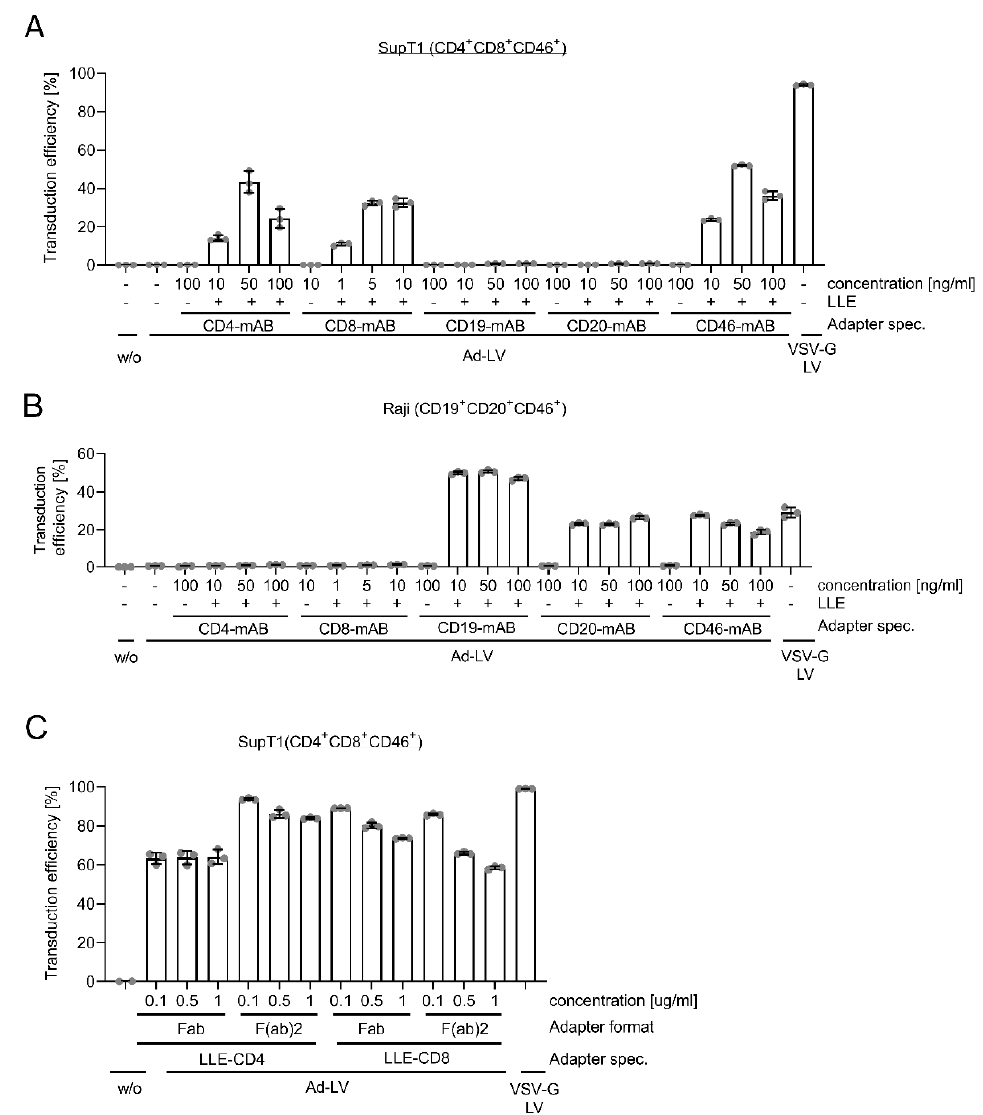
Figure 3. Flexibility of Ad-LV towards adapter specificity and format. The flexibility of the adapter system was evaluated by transduction of cell lines using different adapter specificities. SupT1 (CD4 + CD8 + CD46+) ( A ) and Raji cells (CD19 + CD20 + CD46+) ( B ) were left untreated (w/o) or were transduced with GFP-encoding Ad-LV with 0.2 TU/cell using LLE-CD4 (clone: MT-466), LLE-CD8 (clone: BW135/80), LLE-CD19 (clone: LT19), LLE-CD20 (clone: LT20), and LLE-CD46 (clone: REA312) mABs (+) in concentrations ranging from 1 to 1000 ng/mL. Non-biotinylated mABs (-) used in the highest concentration and transduction in the absence of any adapter (-) were used to confirm specificity. VSV-G LV was used as reference. Transduction efficiency was analyzed 3 days (Raji) or 4 days (SupT1) post transduction via quantification of GFP-positive cells using flow cytometry. ( C ) Transduction efficiency of SupT1 comparing fab and f(ab) 2 adapter formats of the same LLE-CD4 or LLE-CD8 clone with adapter concentrations ranging from 0.1 to 1 µg/mL using a GFP-encoding Ad-LV (0.1 TU/cell). VSV-G LV was used as reference. Data are represented as mean ± SD of 3 technical replicates.